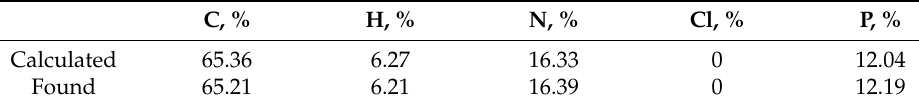
Figure 5. DSC curve of PN-mt melting. Table 2. Elemental composition of PN-mt.